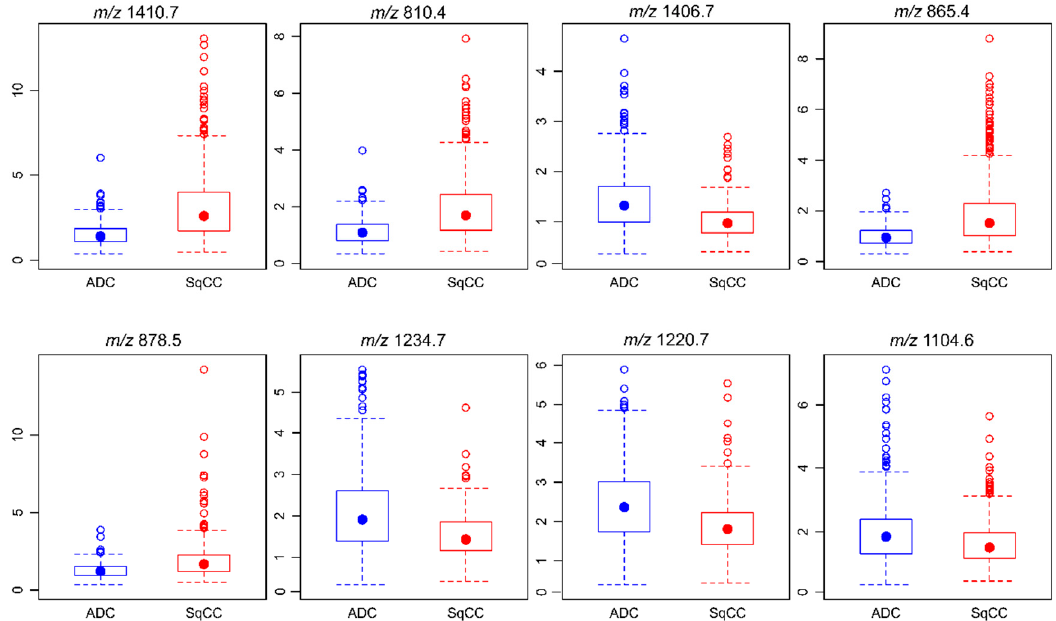
Figure 2. Intensity of m/z values contributing to the classification model regarding the entity. The eight m/z values that contribute most to the random forest model classification of ADC and SqCC are shown. Peak intensities are presented as box plots with regard to the entity. In particular, the median demonstrates the differences in m/z values between the two entities.